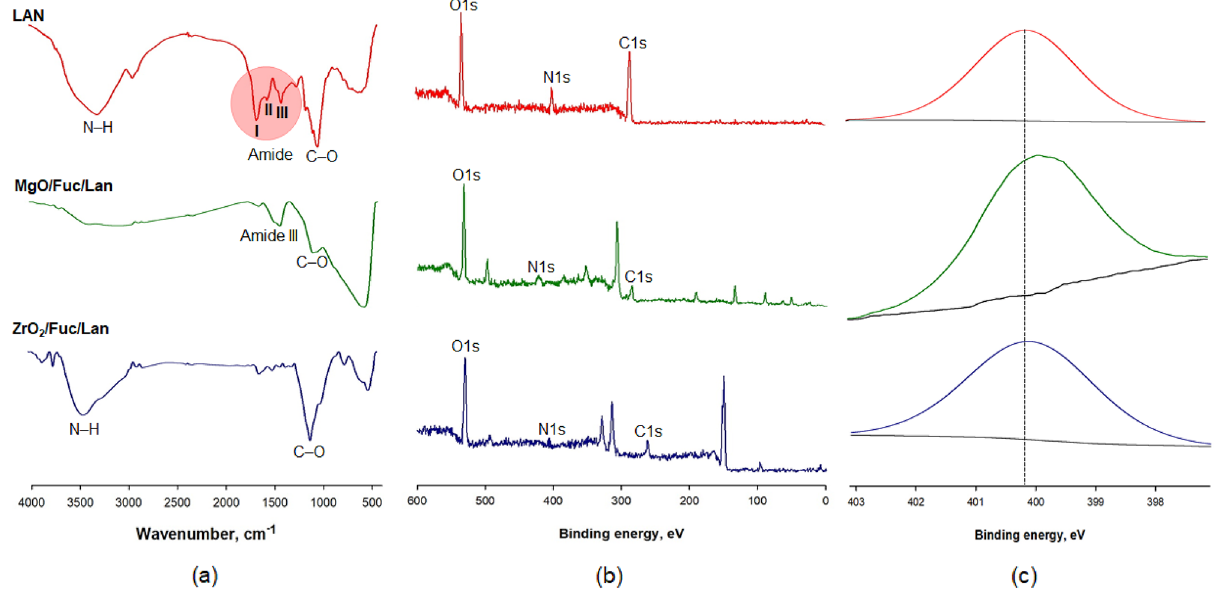
Figure 7. FTIR spectra of lipase, MgO/Fuc/LAN and ZrO 2 /Fuc/LAN ( a ). XPS survey spectra ( b ) and deconvolution of the N 1s line ( c ) for native lipase, MgO/Fuc/LAN and ZrO 2 /Fuc/LAN.